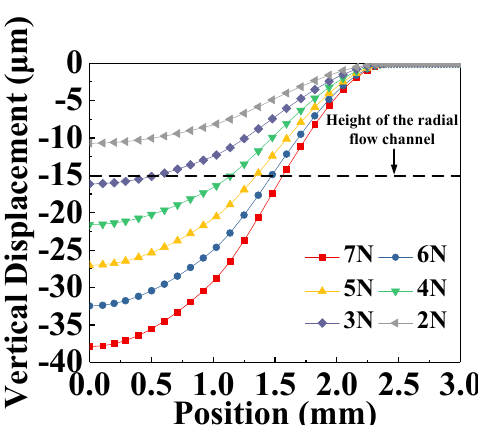
Figure 3. Vertical displacement of the valve membrane under various applied piezoelectric forces with a differential pressure 200